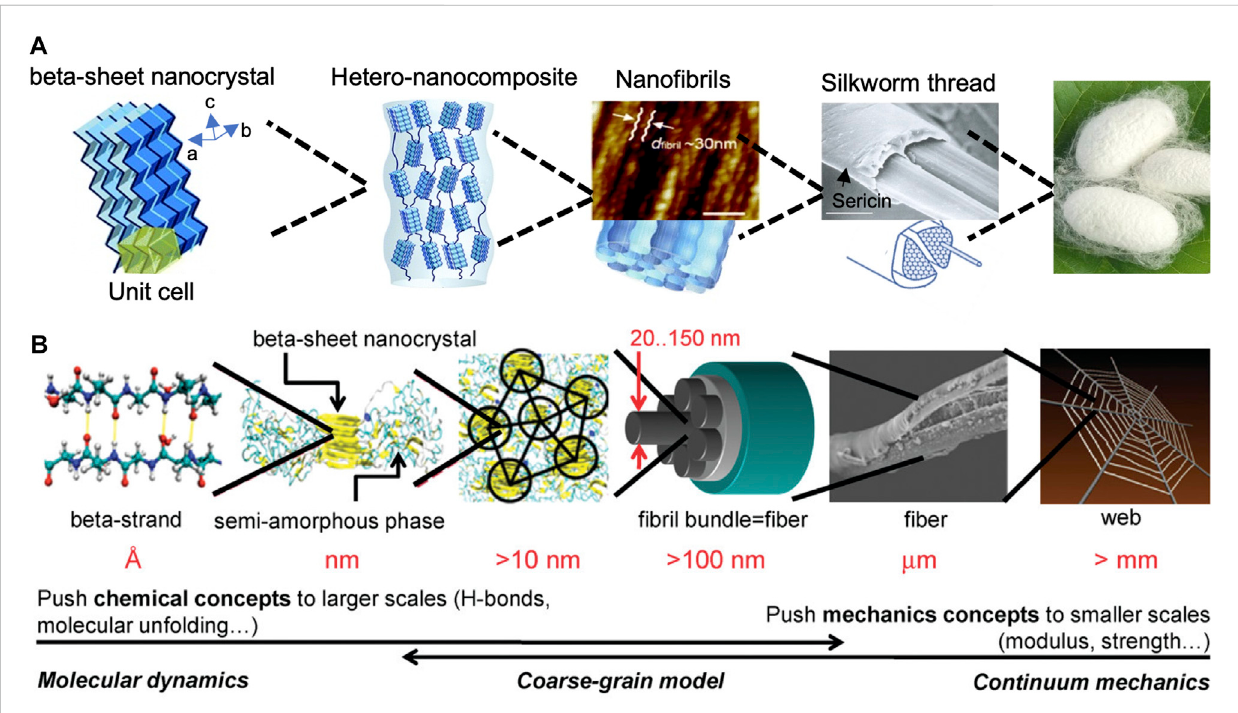
FIGURE 3 The hierarchical structure of (A) silkworm silk and (B) spider dragline silk fi bers. Adapted with permission from ref (Giesa et al., 2011; Xu et al., 2014). Copyright 2014 Royal Society of